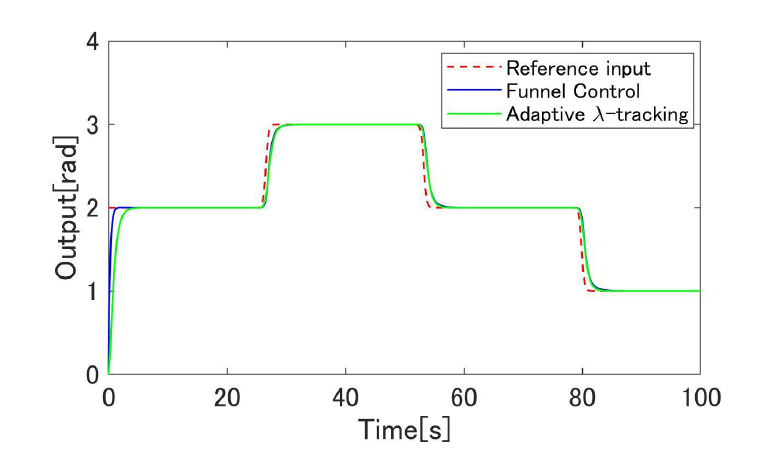
Figure 13. Enlarged view of Figure 12.